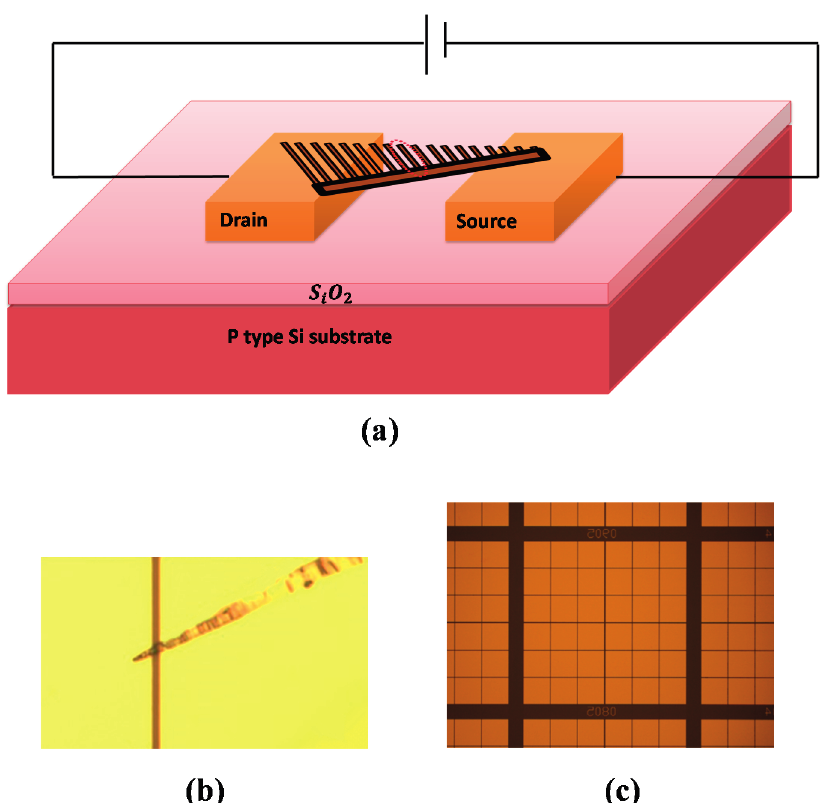
Figure 5. ( a ) Illustration of the ZnO nanocomb based quasi-field-effect-transistor (FET) device; ( b ) photo of the ZnO nanocomb device; ( c ) photo of the patterned electrodes.